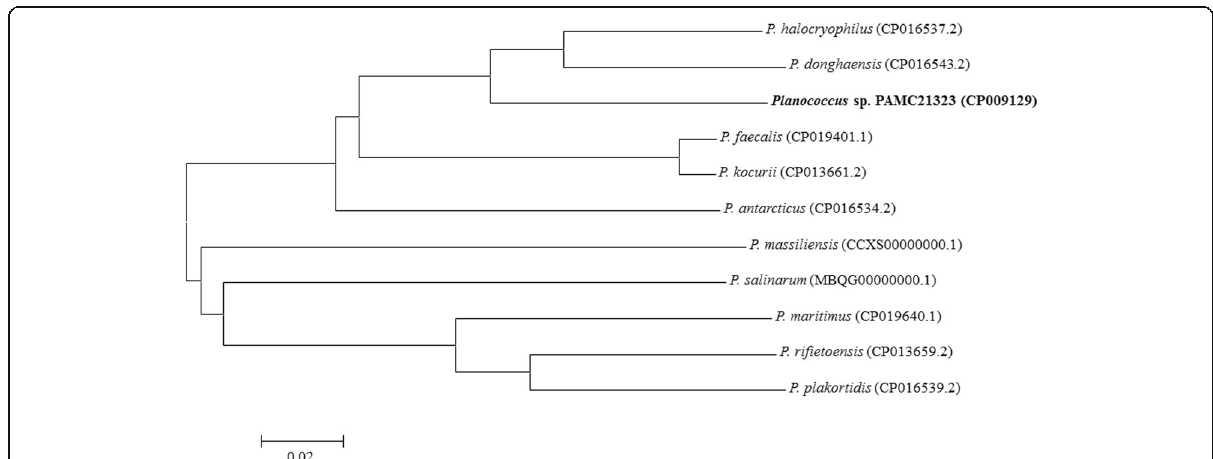
Fig. 2 The relationship of the genome sequences of Planococcus type strains and PAMC21323 based on the average nucleotide identity values. The bar reflects normalized pairwise genomic distance between